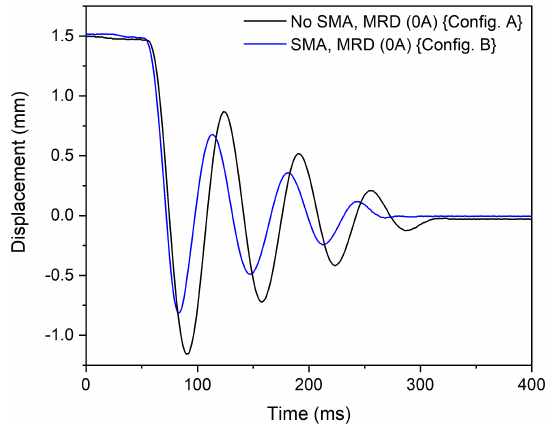
Figure 12. The displacement behaviour of mass with time showing the effect of SMA on shock damping based on ‘Config.